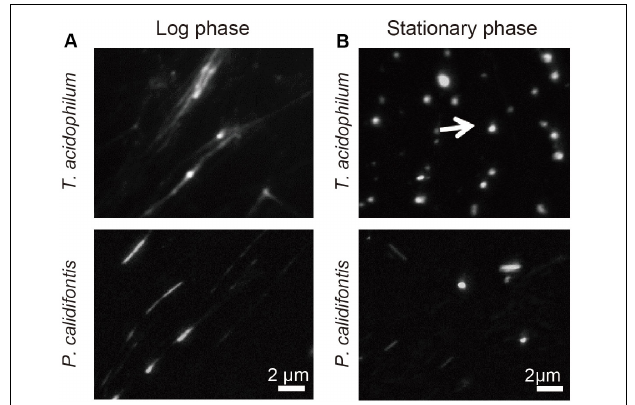
FIGURE 1 | Genomic material released from T. acidophilum and P. calidifontis cells. DAPI staining was performed after on-substrate lysis of the cells during (A) log and (B) stationary phases. Fluorescence microscopy images are shown. (A) Chromosomes were decondensed and elongated in the log-phase for both T. acidophilum (upper panel) and P. calidifontis (lower panel). (B) The stationary phase chromosome was more compact than the log-phase chromosome (arrow). Scale bars: 2 µ